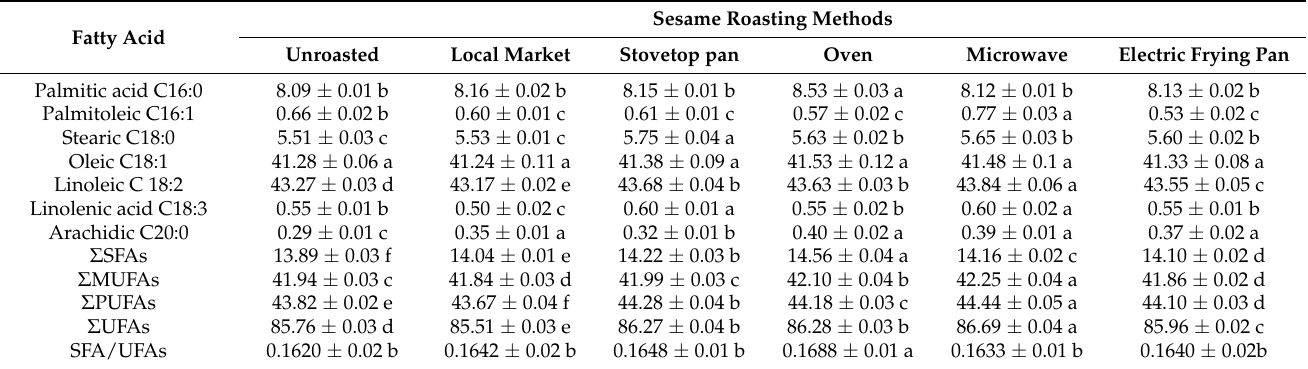
Table 2. Fatty acid (%) profiles of oil recovered from unroasted and roasted sesame seeds with different roasting